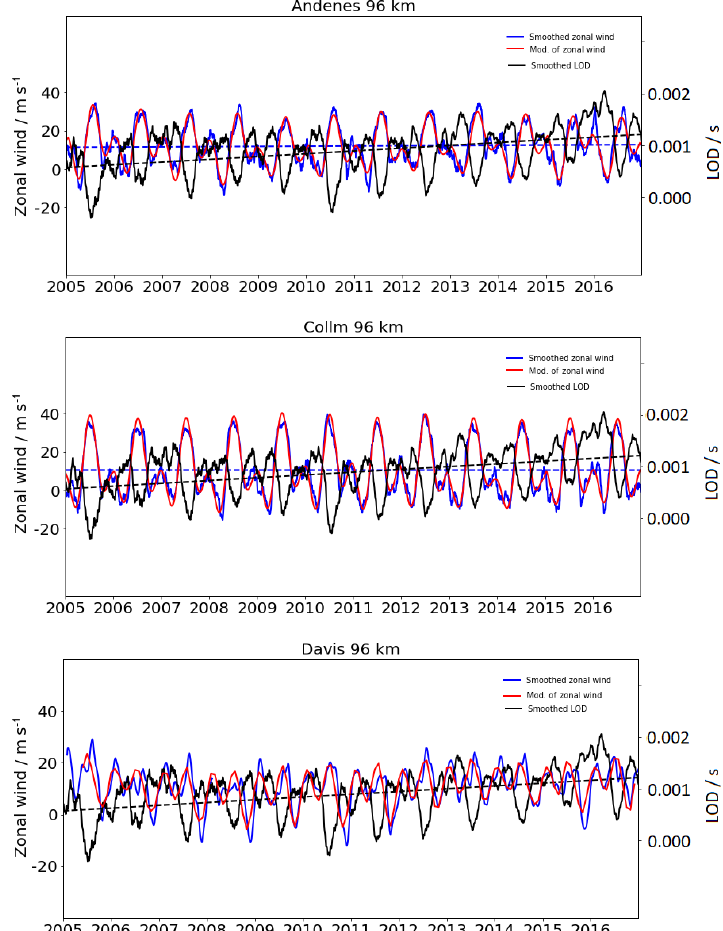
Figure 7. Same as Fig. 6, but for